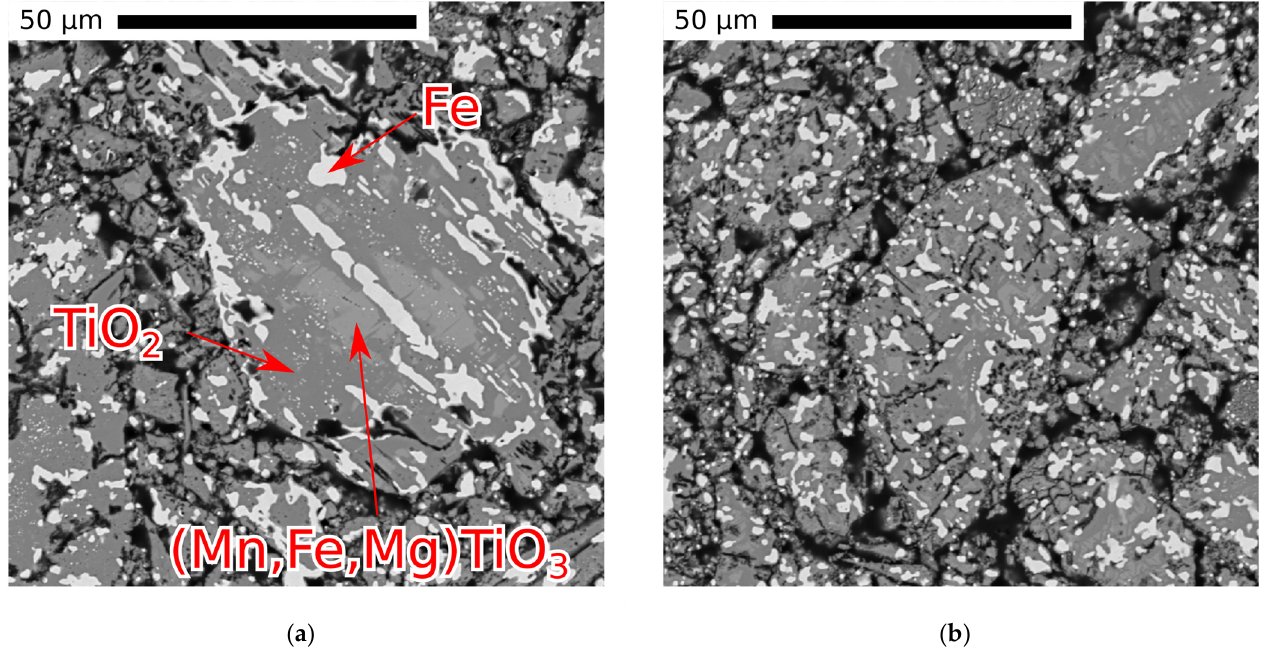
Figure 9. Electron probe micrographs of a pellet reacted at 910 °C for 180 min with a gas containing 98%H 2 . ( a ) View of the inner part of the pellet; ( b ) view of the outer layer of the pellet.